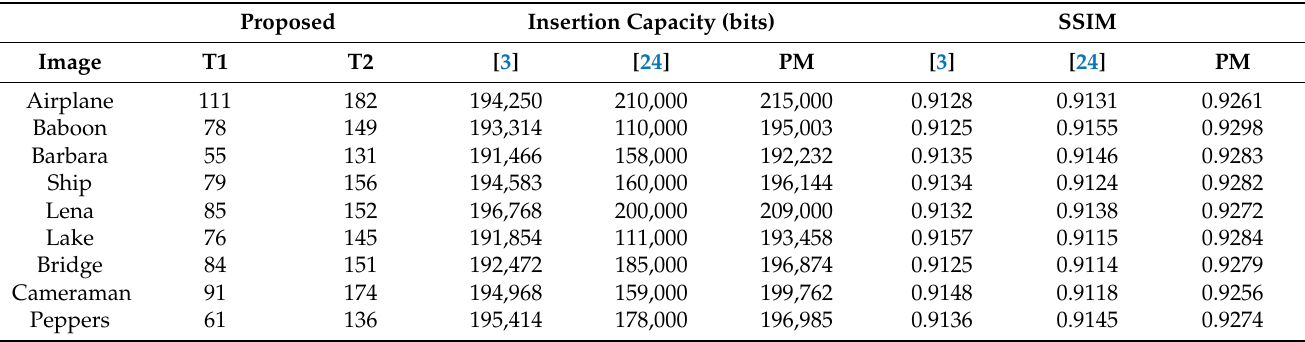
Table 6. Comparison of the SSIM in common images for different capacities.